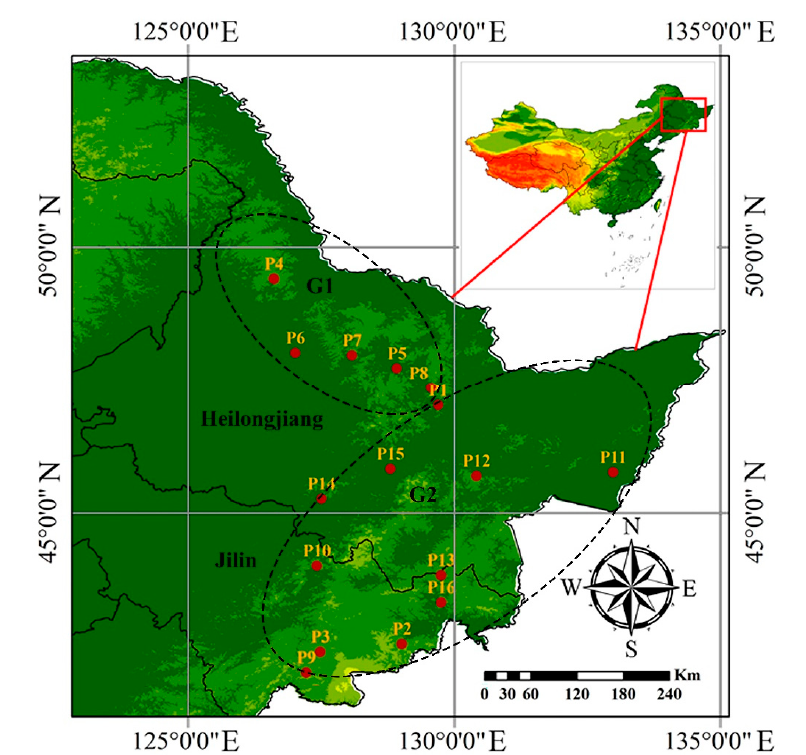
Figure 6. Distribution of Pinus koraiensis populations sampled in northeast China. G1 represents Xiaoxinganling Mountains geographical groups. G2 represents Changbaishan Mountains geographical groups. Table 5. Summary of Pinus koraiensis sampled populations in NE China.